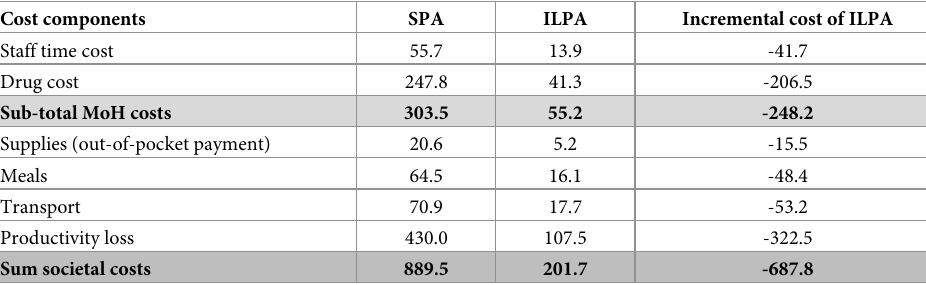
Table 2. Costs per patient treated (2017